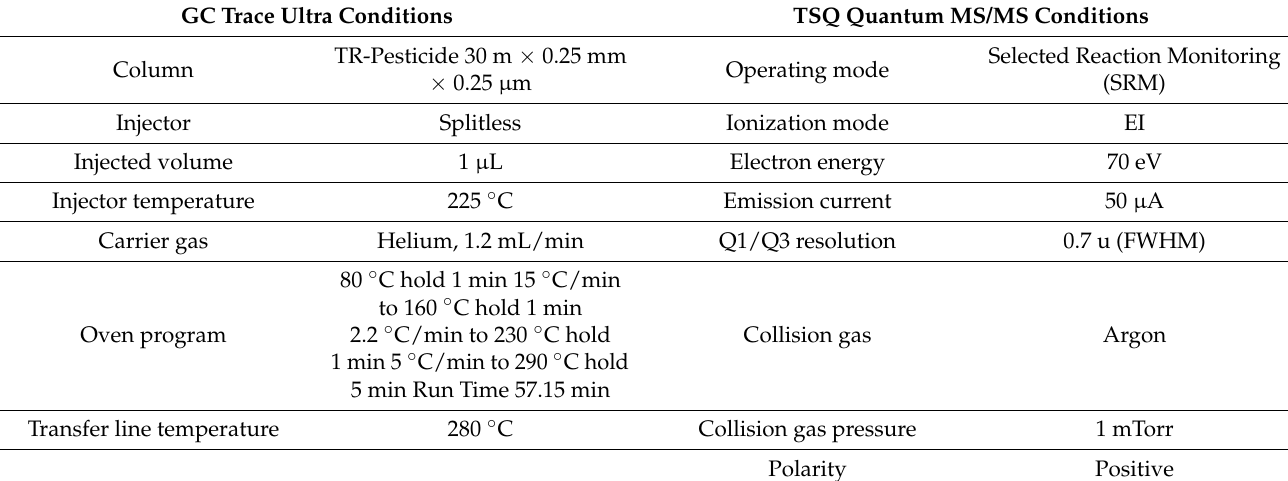
Table 1. Gas chromatography–tandem mass spectrometry with triple quadrupole detector (GC–MSMS/TSQ) 8000 SRM instrumental conditions.